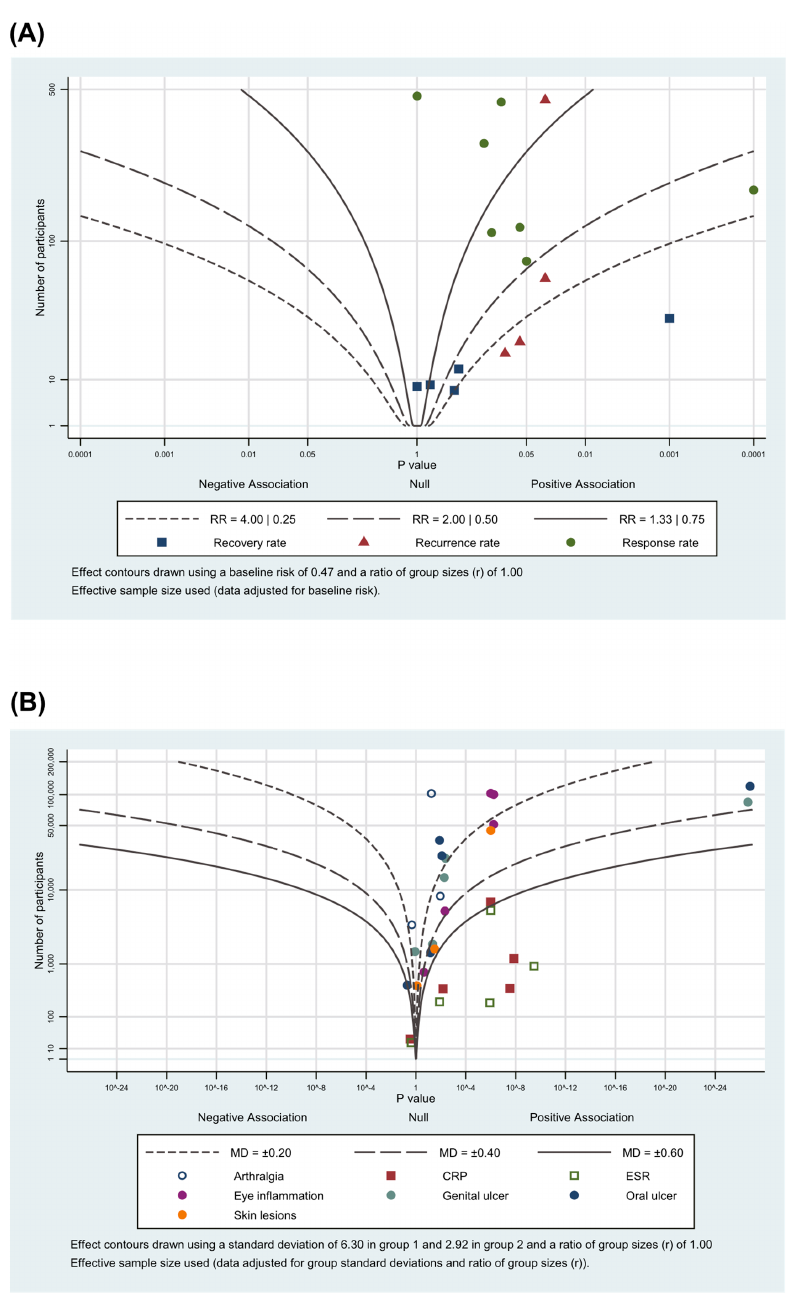
Figure 5. Albatross plot for ( A ) primary outcomes; ( B ) secondary outcomes.